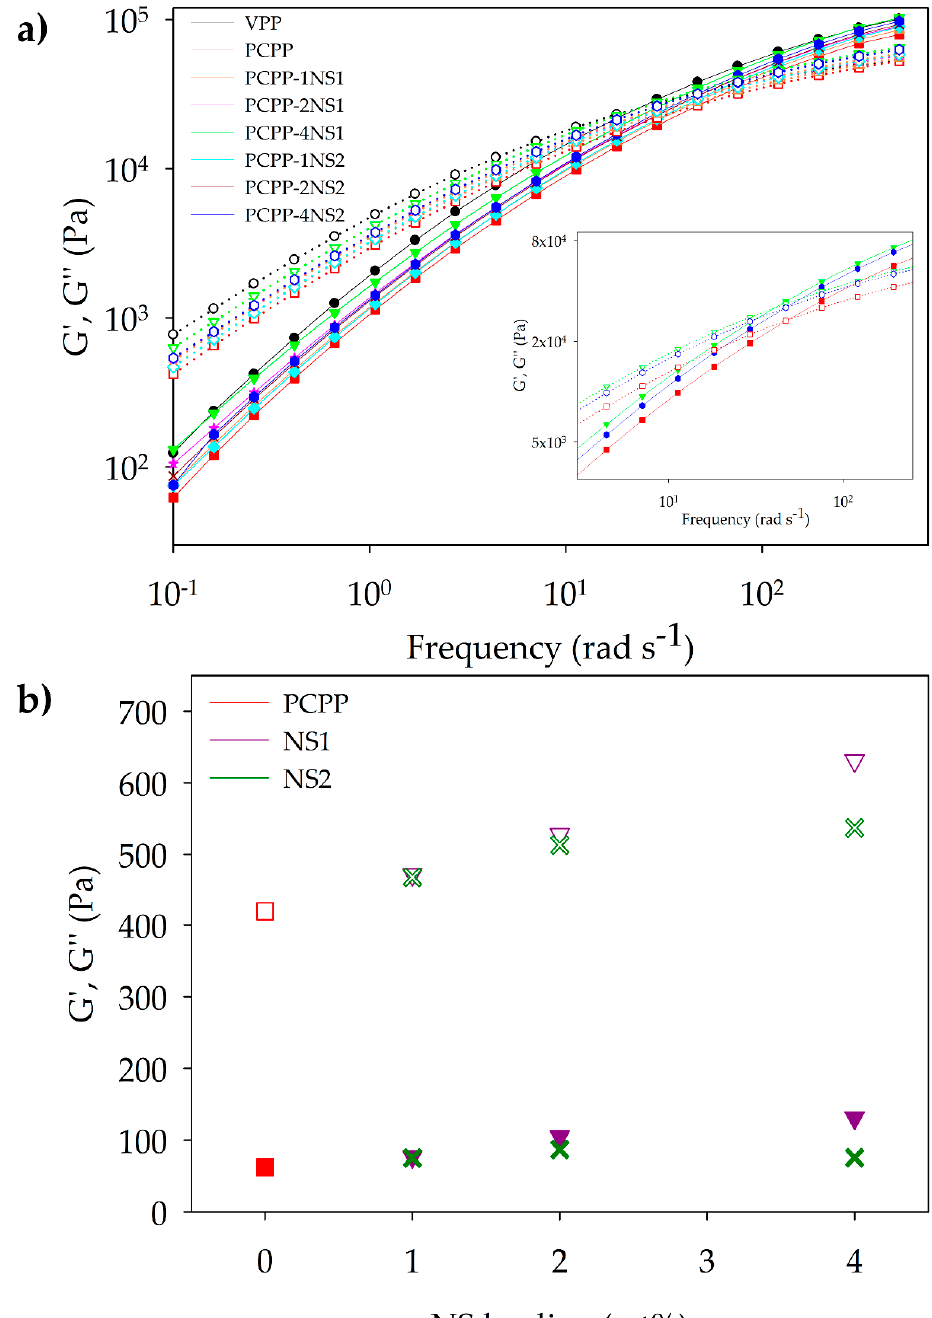
Figure 4. Storage modulus (G ′ ) and loss modulus (G ″ ) of the samples as a function of ( a ) the angular frequency (insert of the intersection of G ′ and G ″ curves for PCPP, PCPP-4NS1 and PCPP-4NS2 and ( b ) fumed silica loading. G ′ and G ″ plots of a sample have the same color and marker shape, but filled and empty marks correspond to G ′ and G ″ modulus, respectively.